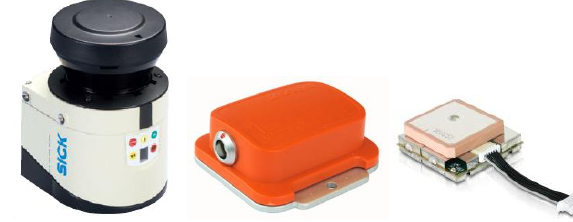
Fig. 10: SICK Scanner LMS 151, IMU - Xsens MTI-